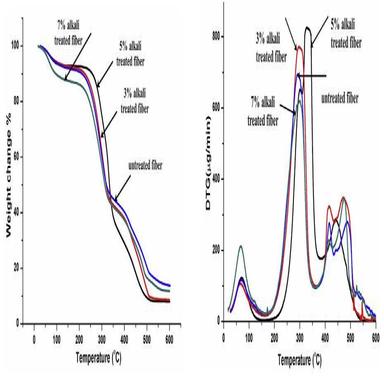
TGA and DTG thermograms of untreated and treated fibers.